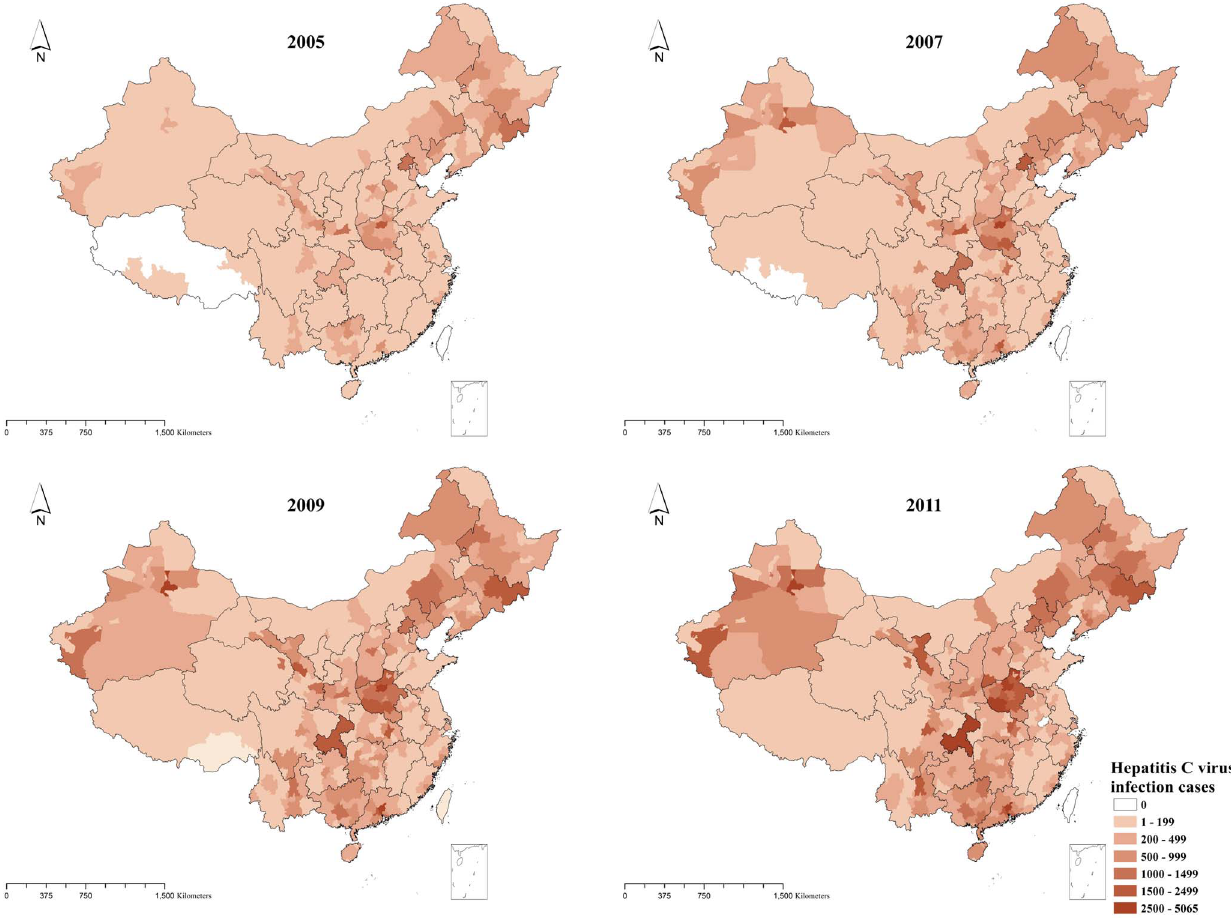
Figure 2. Geographical distribution of the number of identified HCV infection cases reported at city level in the years 2005, 2007, 2009 and 2011 in China.